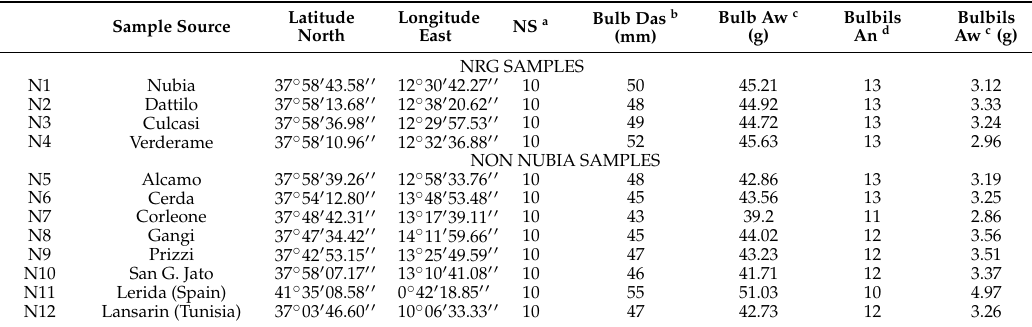
Table 1. General information about the studied garlic